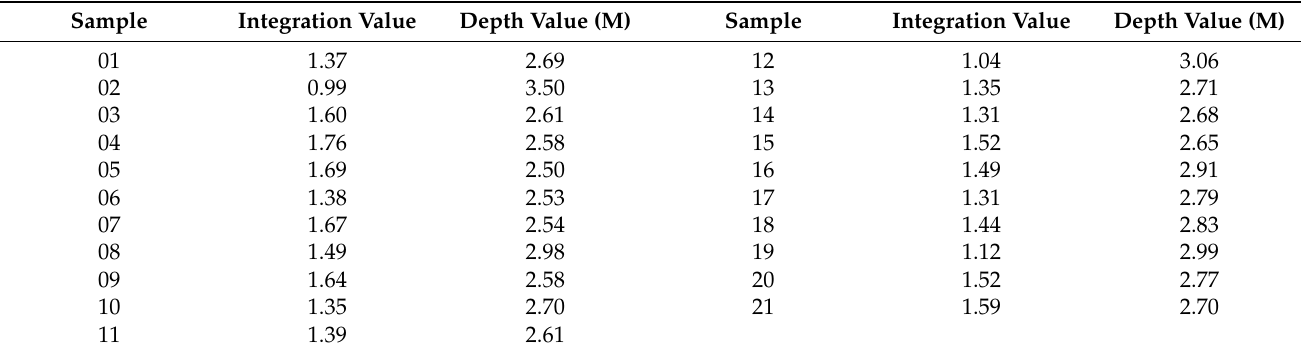
Table 2. Mean depth and integration properties of different kitchens.